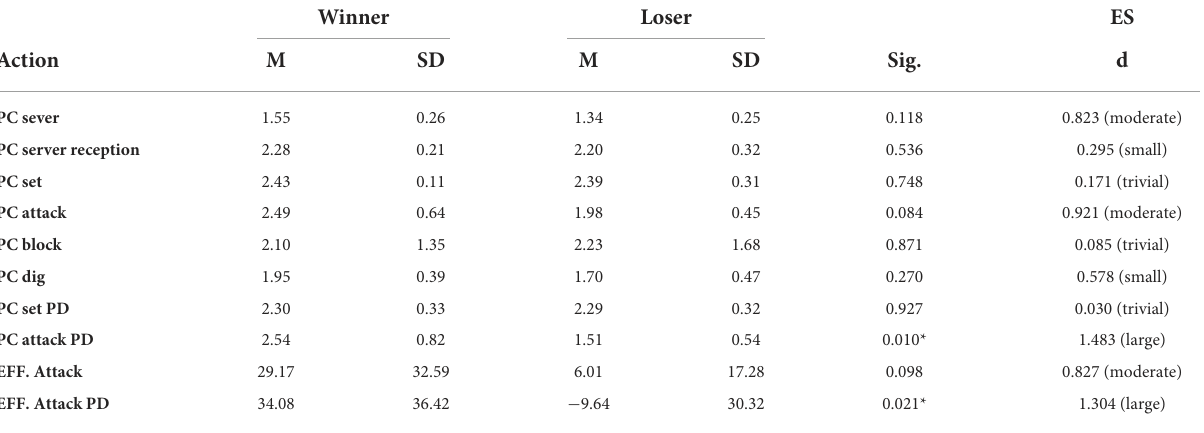
TABLE 1 Mean and standard deviation of technical-tactical performance indicators as a function of the set outcome. Winner Loser ES Action M SD M SD Sig.